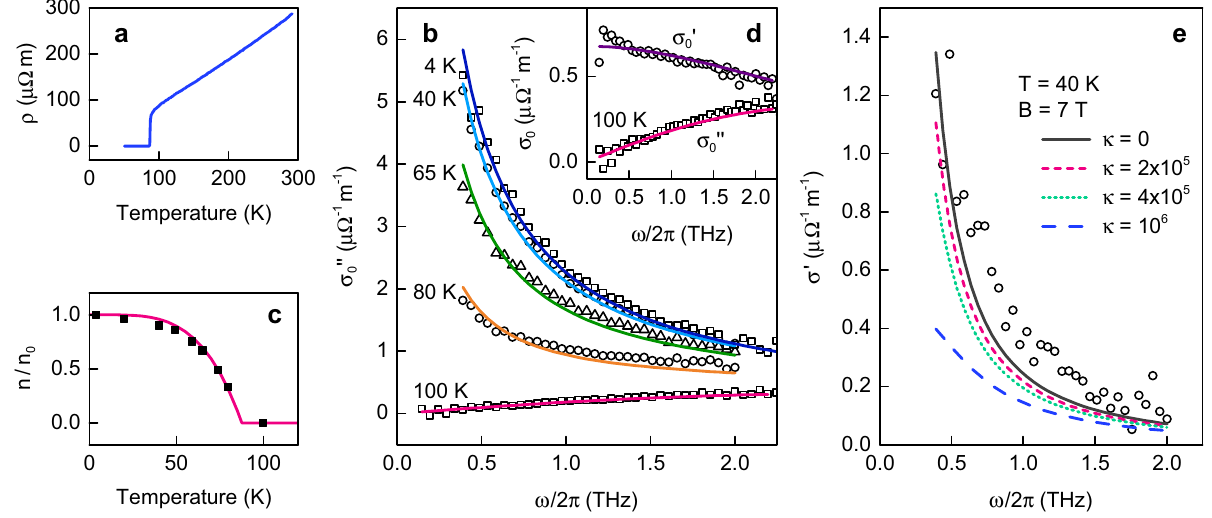
Figure 2. Sample specification. Panels ( a – d ) refer to the zero magnetic field. ( a ) The dc resistivity as a function 87.6 K. Extrapolation of the normal-state resistivity of temperature provides the critical temperature T c = below T c gives negligible residual resistivity. ( b ) The imaginary part of conductivity as a function of frequency for several temperatures. The two-fluid model (lines) reproduces the data (symbols) for the superconducting 1 T 4 / T 4 fraction f s c (line), which is compared in ( c ) with the fitted values. ( d ) The real (circles) and = − imaginary (squares) components of the complex conductivity at 100 K provide the relaxation time τ N ( e ) The measured real part of conductivity for linearly polarized light at magnetic field 7 T (circles) compared 1 σ ) , supports small pinning with κ with fits based on the vortex dynamics, σ 2 (σ = + + −